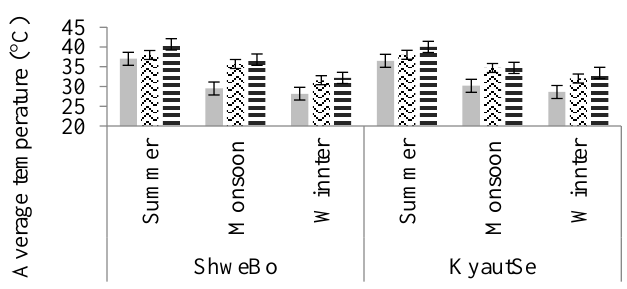
Figure 6. Five-year average seasonal temperature (°C) for 2013-2017 and 2008-2012.